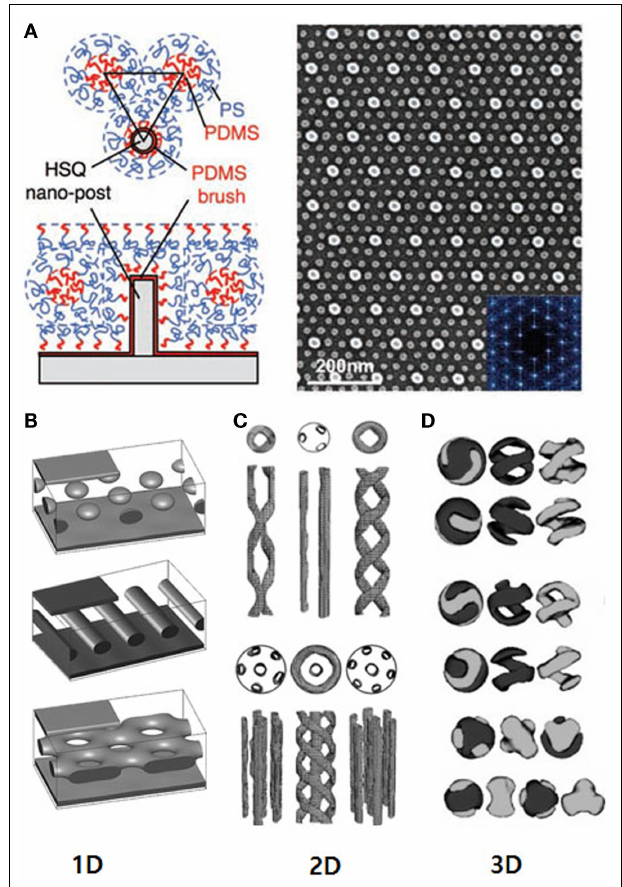
FIGURE 1 | (A) Top-down and side-view schematics showing the arrangement of PS-b-PDMS BCP molecules in the region surrounding a single post made from cross-linked HSQ resist and its SEM image. [Reprinted with permission from Bita et al. (2008), Copyright 2008 American Association for the Advancement of Science.] New nanostructures in all kinds of dimensions via simulation investigation; (B) 1D using thin film template. [Reprinted with permission from Li et al. (2013). Copyright 2013 American Chemical Society.] (C) 2D using cylindrical template [Reprinted with permission from Yu et al. (2006). Copyright 2006 American Physical Society], and (D) 3D using spherical nanopores. [Reprinted with permission from Yu et al. (2007). Copyright 2007 American Chemical